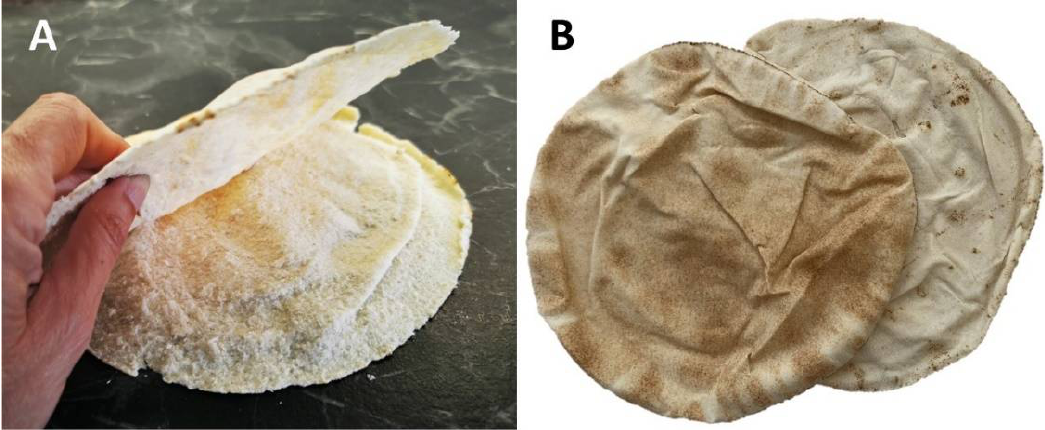
Figure 2. ( A ) Jordan Kmaj opened to show the internal “pocket”. ( B ) Lebanese Khobz . The pocket is the visible result of the thermal expansion of the fermentation gas into a thin dough layer, which takes place during baking (Figure